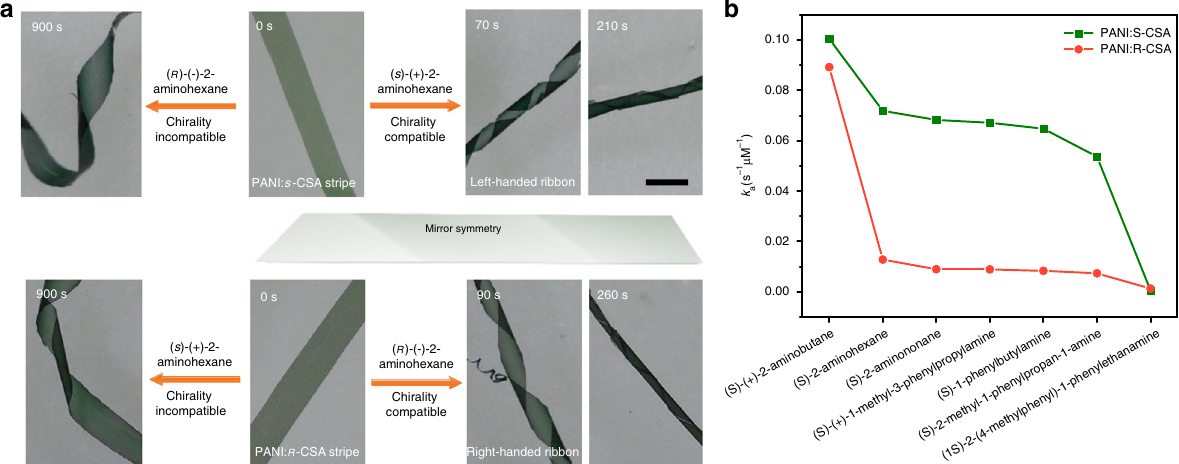
Fig. 5 Chirality perception of the macro stripe. a The upper half, the PANI: s -CSA stripe exposed to ( s )-( + )-2-aminohexane and ( ʀ )-(-)-2-aminohexane in THF. The bottom half, the PANI: ʀ -CSA stripe exposed to ( s )-( + )-2-aminohexane and ( ʀ )-(-)-2-aminohexane in THF. Disparate actuation behaviours over time can be observed when the stripes responded to chiral stimuli from different enantiomeric aminohexanes. Scale bar corresponds 0.5 mm. b the de- doping apparent rate constant k a of a series of chiral target amine species for PANI stripes doped by enantiomeric